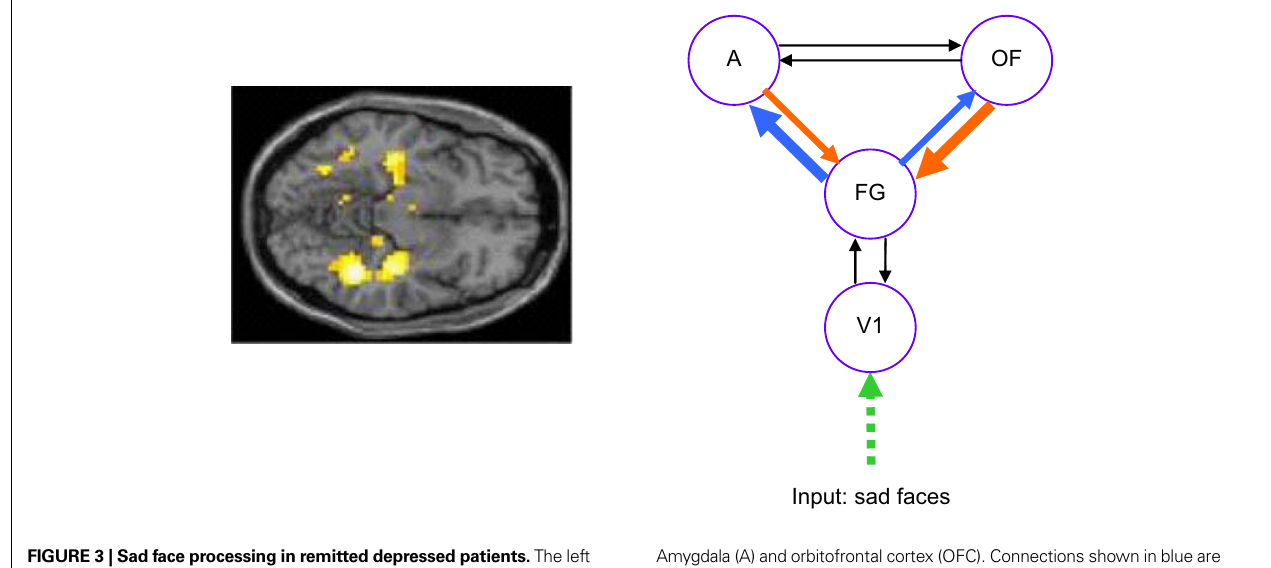
FIGURE 3 | Sad face processing in remitted depressed patients. The left panel shows attenuated bilateral hippocampus and fusiform signal in patients compared to controls. The right panel shows altered connectivity in patients obtained via dynamic causal modelling. The model tested was a right hemisphere model comprising primary visual cortex (V1), fusiform gyrus (FG),